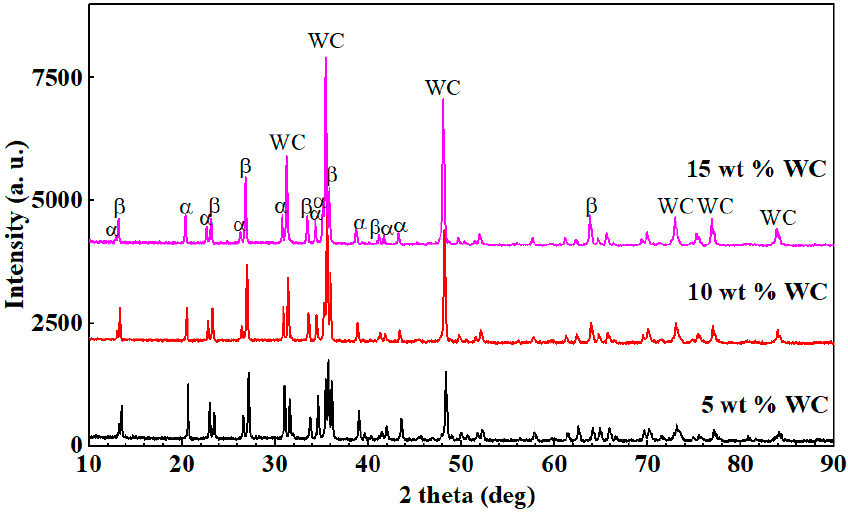
Figure 5. Effect of the WC content on the phase composition of the Si 3 N 4 -based ceramic material.